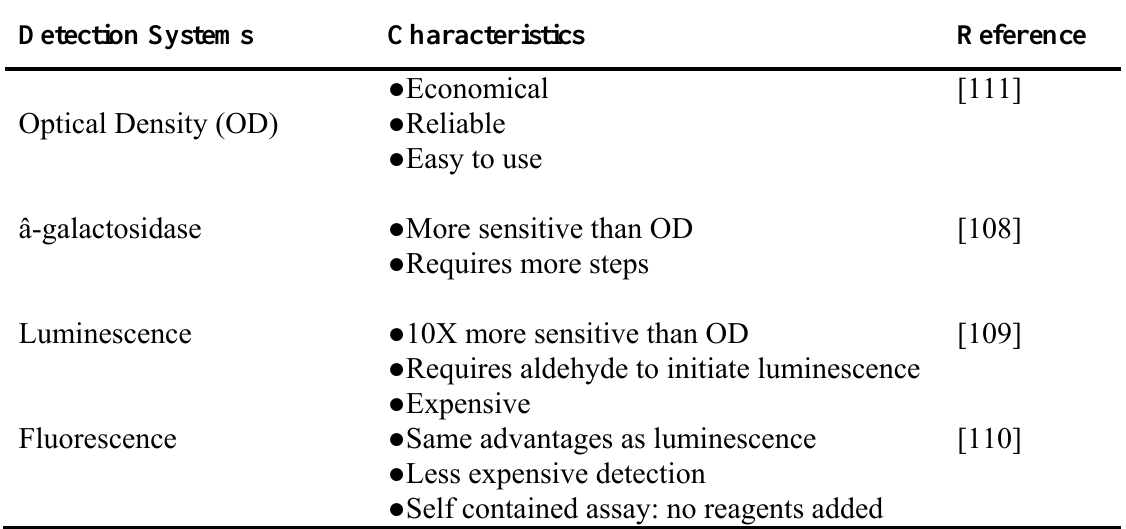
Table 2 . Detection systems for microbial